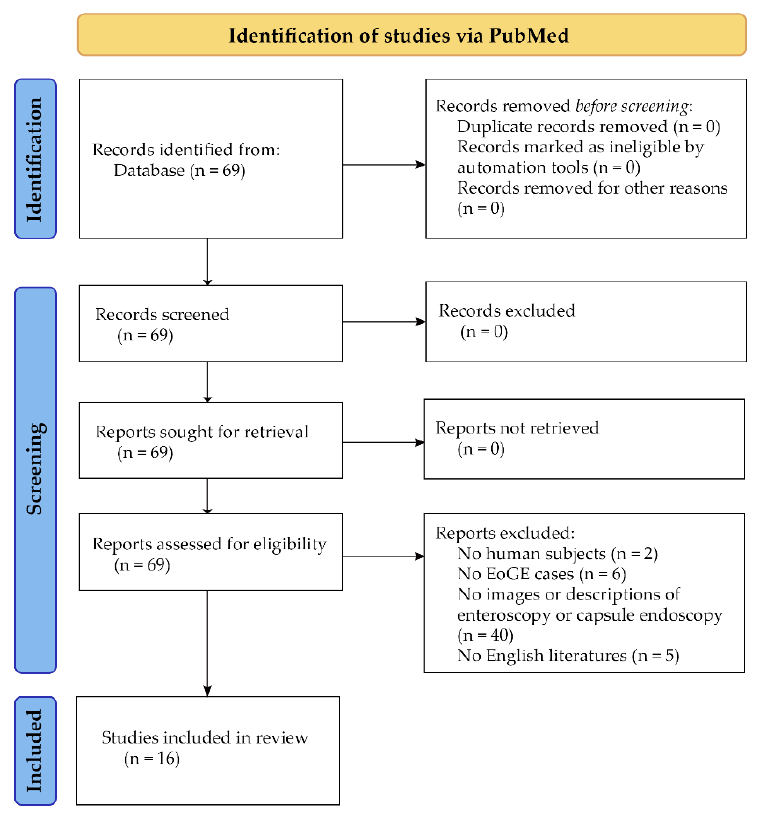
Figure 1. Flow diagram for identification of studies via PubMed.